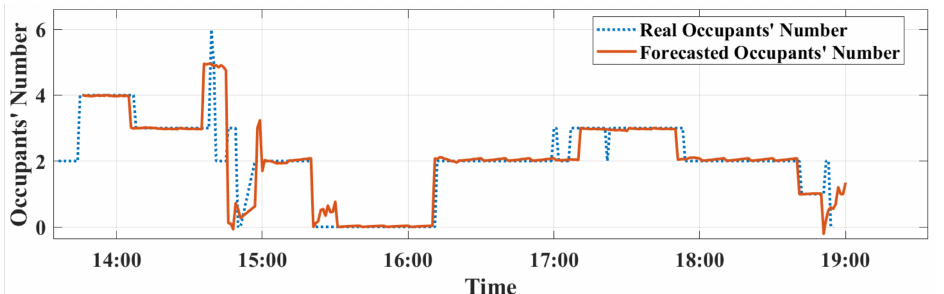
Figure 11. Occupancy forecasting results using LSTM.